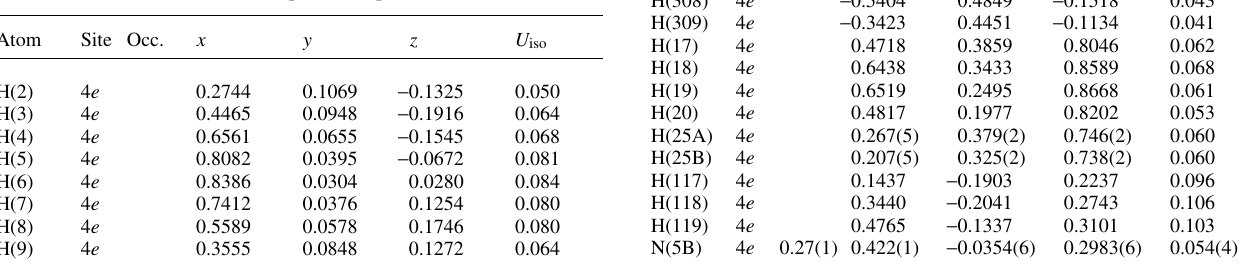
Table 2. Atomic coordinates and displacement parameters (in Å 2 ) .